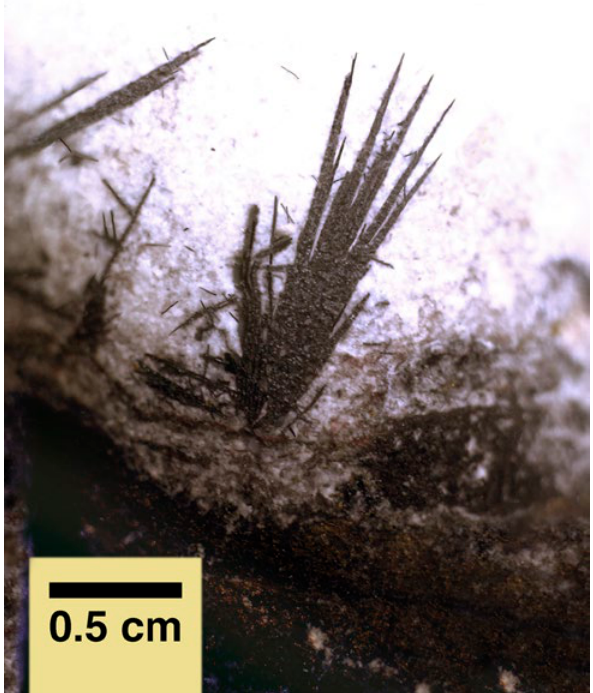
Figure 82. Radiating acicular hematite needles have grown out like spikes into a gelatinous dolomite precursor of the lode at Juno Mine, Tennant Creek. This ‘wild growth’ from a central nucleation point is typical of bladed and spherulitic crystal patterns developed in gelatinous media where enhanced (catalytic) crystal growth on one of the small seed crystal faces proceeds almost to the exclusion of growth on other